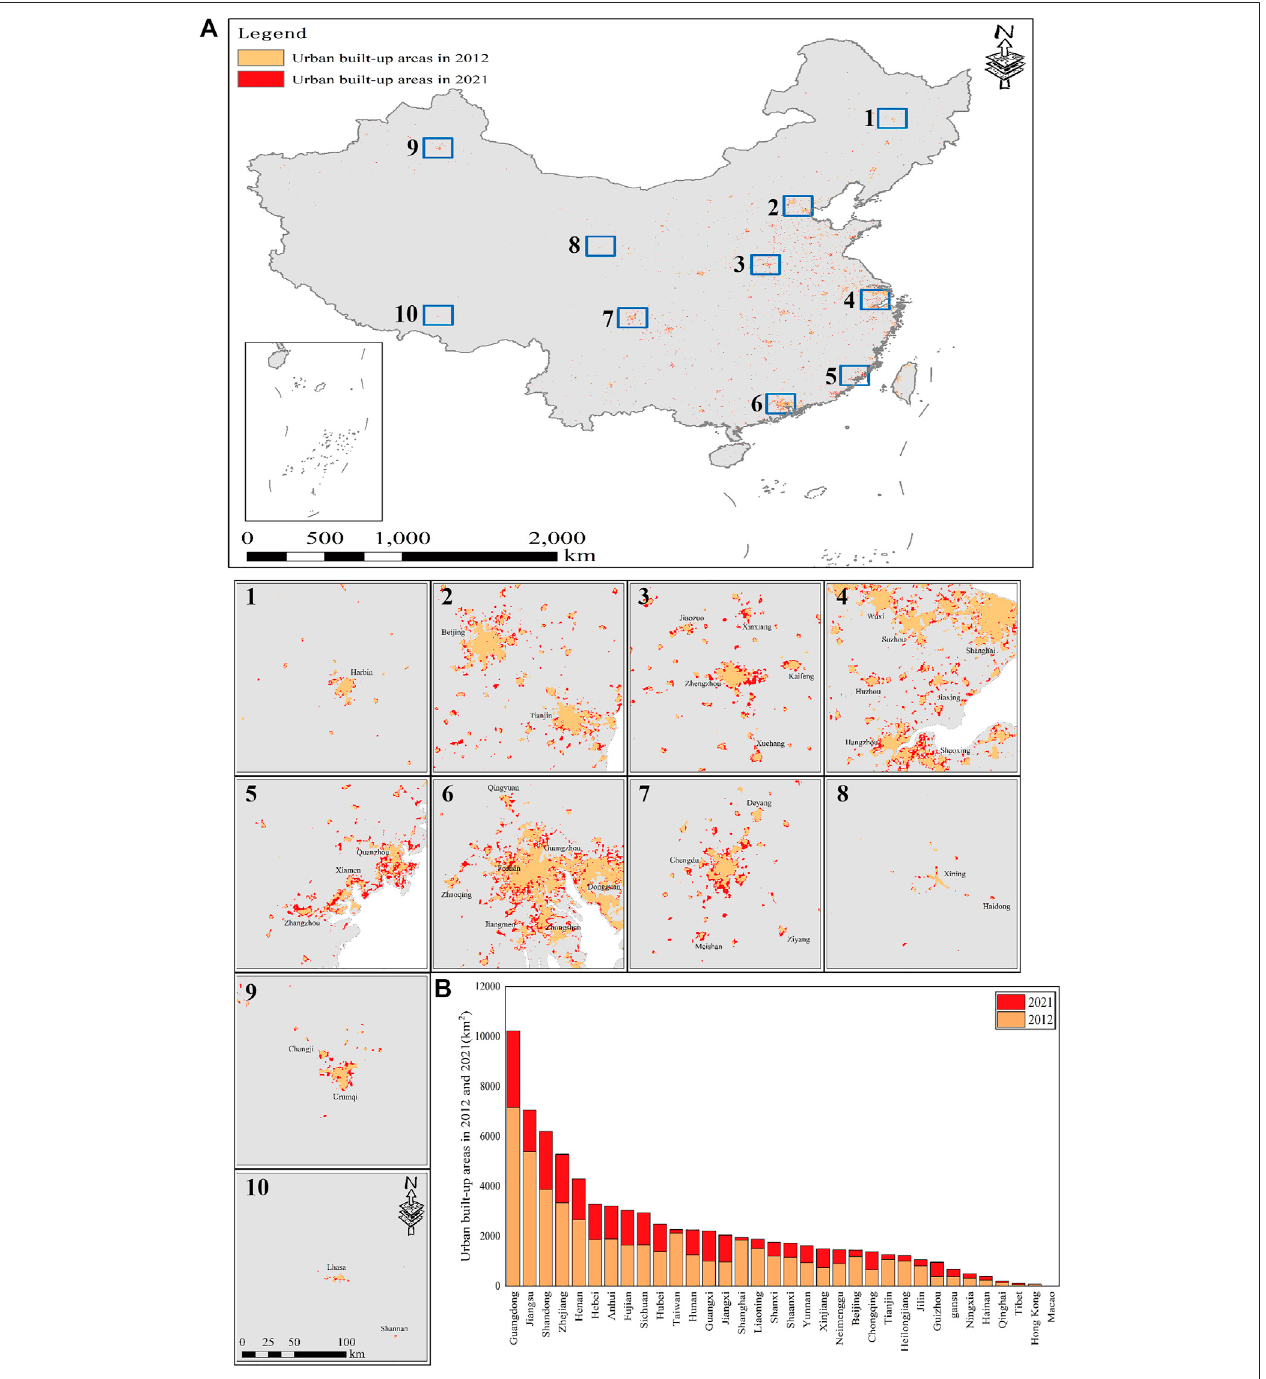
FIGURE 7 | Expansion of urban built-up areas in China from 2012 to 2021. (A) Expansion of urban built-up areas in some cities (including developed, moderately developed, and underdeveloped). (B) Urban built-up area expansion by provinces.